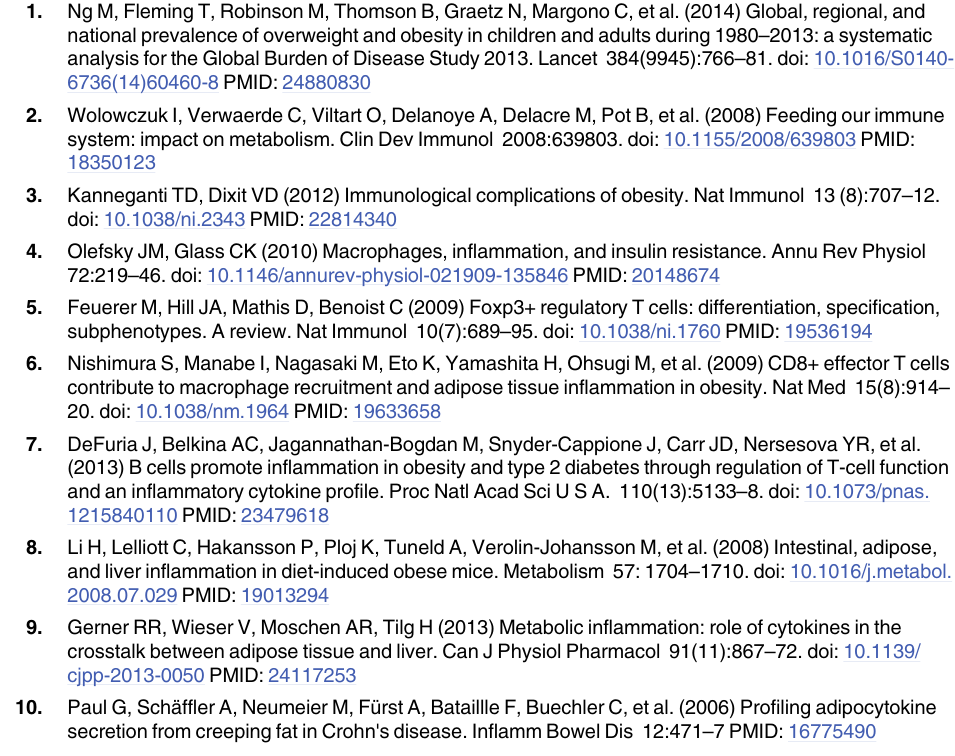
detected in faeces of different mouse groups